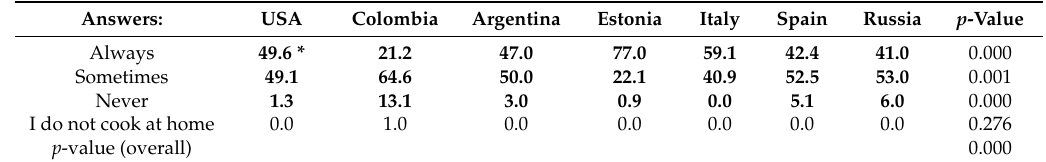
Table 2. When you cook at home, do you usually save leftovers? Results given in % of respondents.